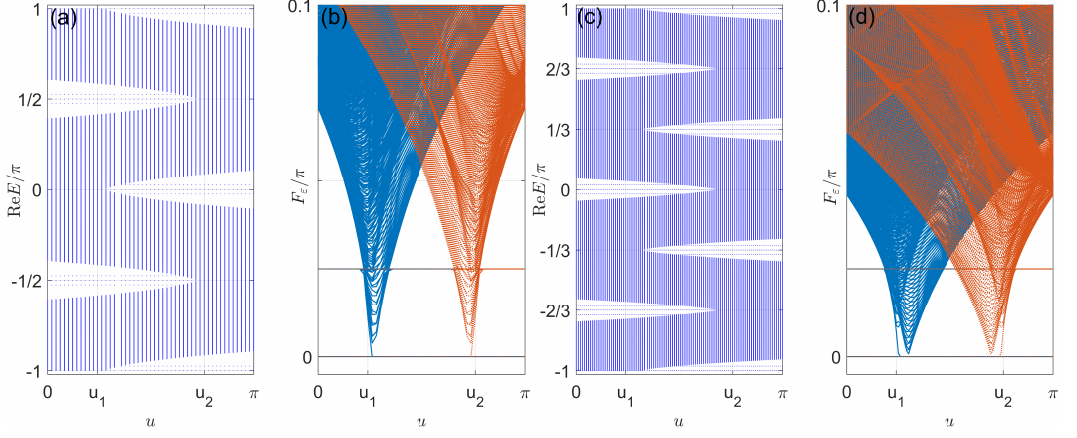
[ Eq. (31) ] Figure 5: Floquet spectrum E and gap function F (cid:34) of U 1 / 2 [ Eq. (32) ] versus u . Other system parameters are set as and U 1 / 3 ( J , J , ∆ , v ) = ( 0.5 π ,5 π ,0.05 π ,0.5 ) . The lattice size is L = 2000 along each 1 2 spatial direction. (a) and (c) show the values of the real part of E for the square- and cubic-root models described by U and U , respectively. The blue solid and 1 / 2 1 / 3 red dotted lines denote the gap functions F ( = F π ) and F π/ of U in (b), and the 0 2 1 / 2 gap functions F π/ ( = F π ) and F ( = F ) of U in (d). u and u denote critical 3 2 π/ 3 0 1 / 3 1 2 values of u where the spectral gap closes and the number of corner modes changes across the topological phase transition, which are obtained from Eq.